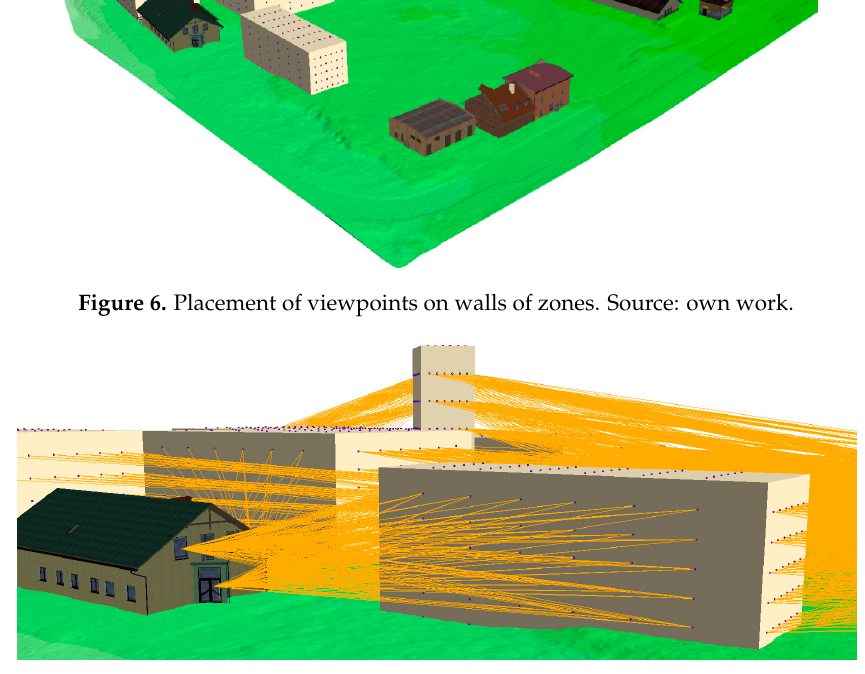
Figure 6. Placement of viewpoints on walls of zones. Source: own work